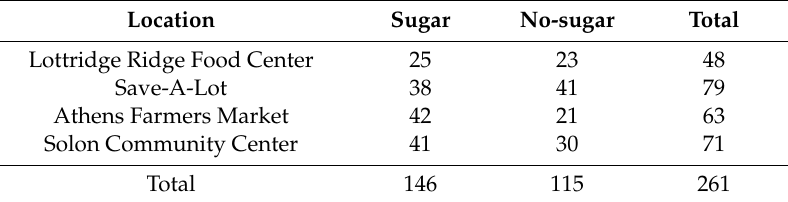
Table 1. Sample Size in Di ff erent Locations by Experimental